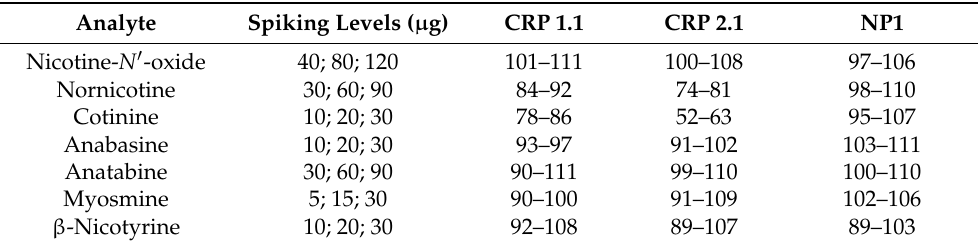
Table 6. Accuracy data (%) for CRP 1.1, CRP 2.1 and